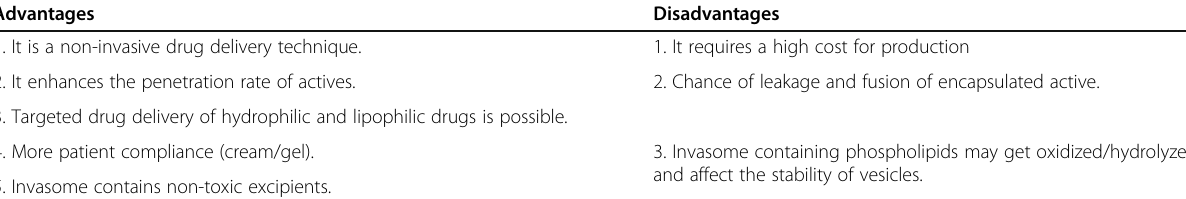
Table 1 Invasome advantages and